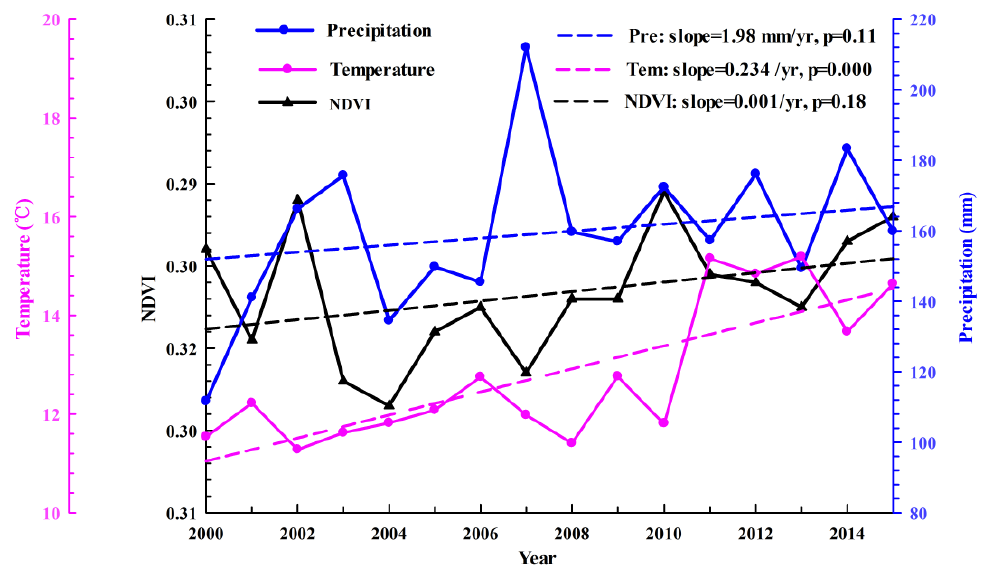
Figure 4. Interannual variation trends of the growing season NDVI, precipitation, and temperature around the Hexi Corridor from 2000 to 2015.